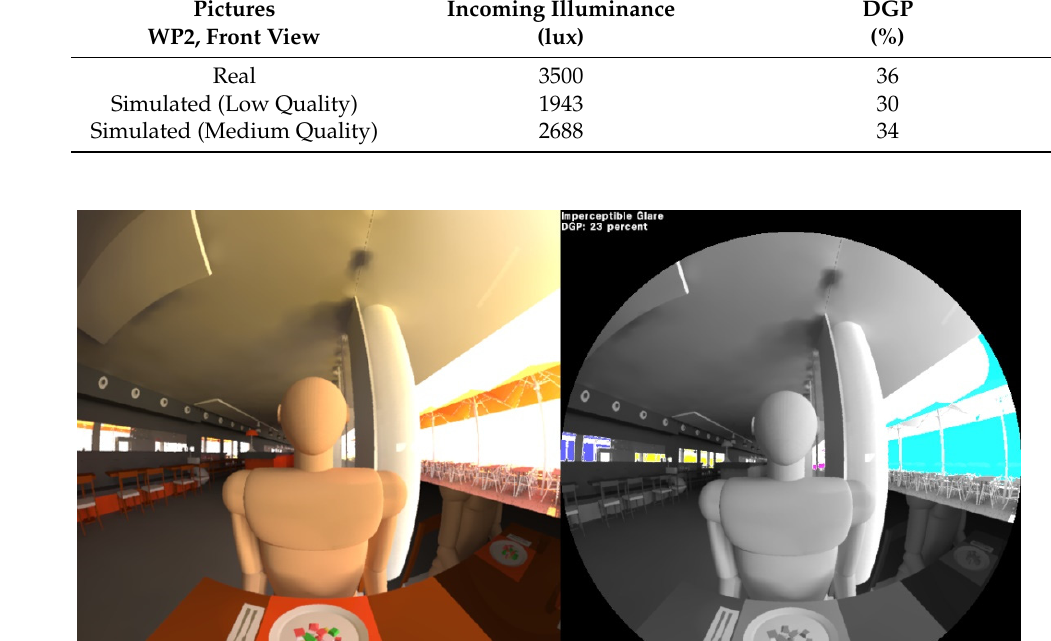
Table 2. Comparison of incoming illuminance and DGP results of real and simulated pictures.